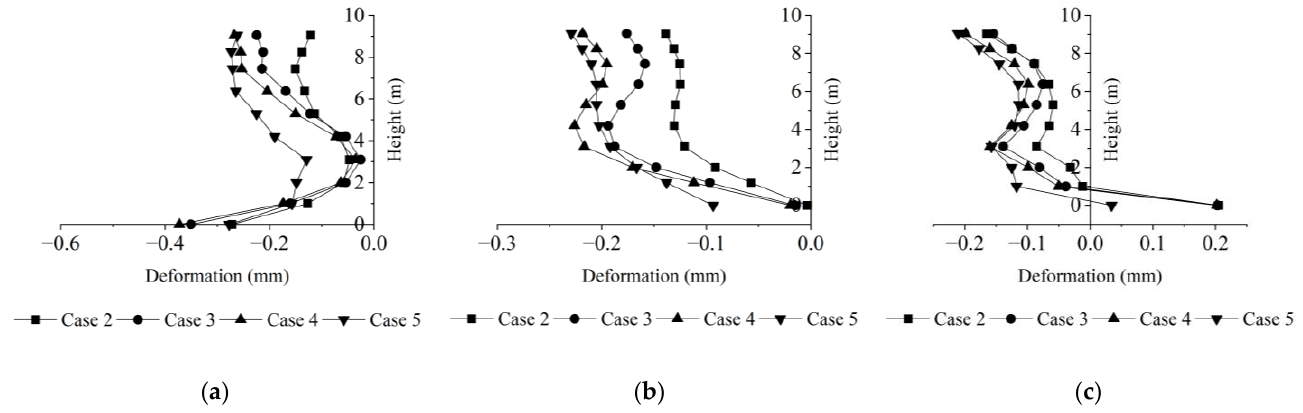
Figure 14. Lateral deformation of structural wall subjected to symmetric construction: ( a ) northern wall; ( b ) middle wall and ( c ) southern wall (unit: mm).